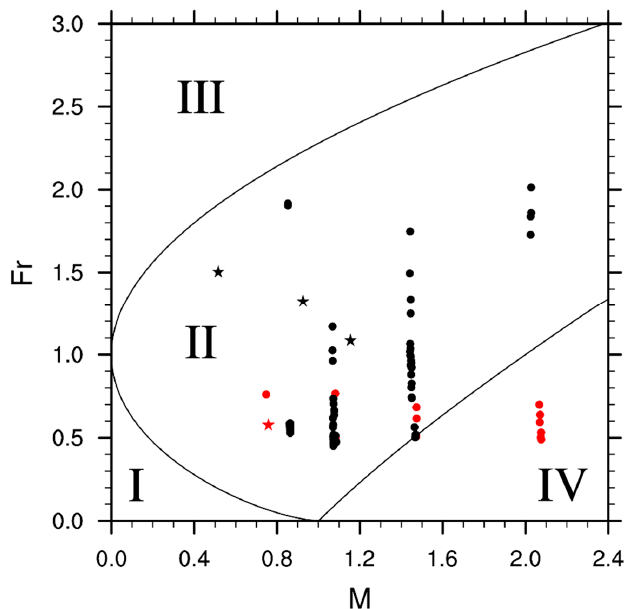
Figure 7. Diagram for asymptotic solutions to shallow water flow over an isolated obstacle as a function of the Froude number and dimensionless height. The red and black dots (stars) represent the condition of simulated (observed) incoming flow before 0400 LT and after 0400 LT, respectively. 69 samples in the simulation and 4 observed samples are used for this diagram.